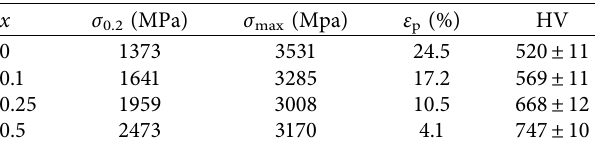
0.5 Ni HEA with different Fe